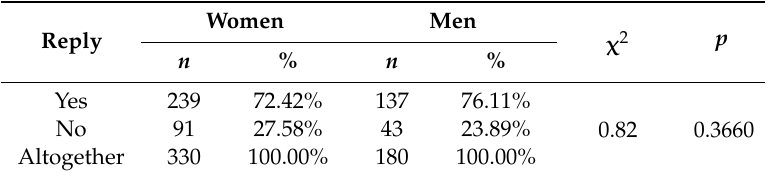
Table 4. Study about the motivation to undertake PA due to cheering in the 6th Poznan Half Marathon—depending on sex.